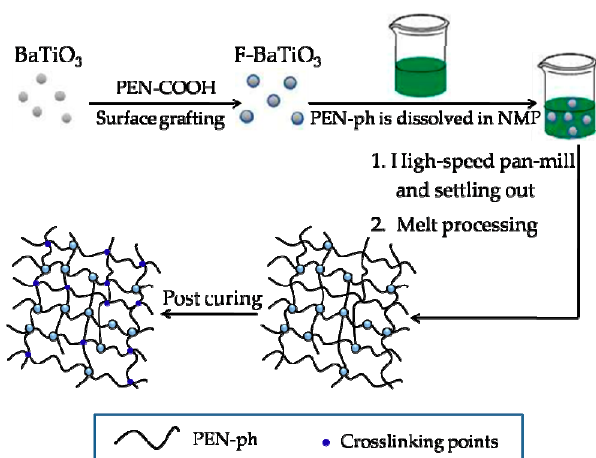
Figure 2. Schematic illustration for the surface modification of BaTiO 3 particles and preparation of CPEN/F-BaTiO 3 composite films.